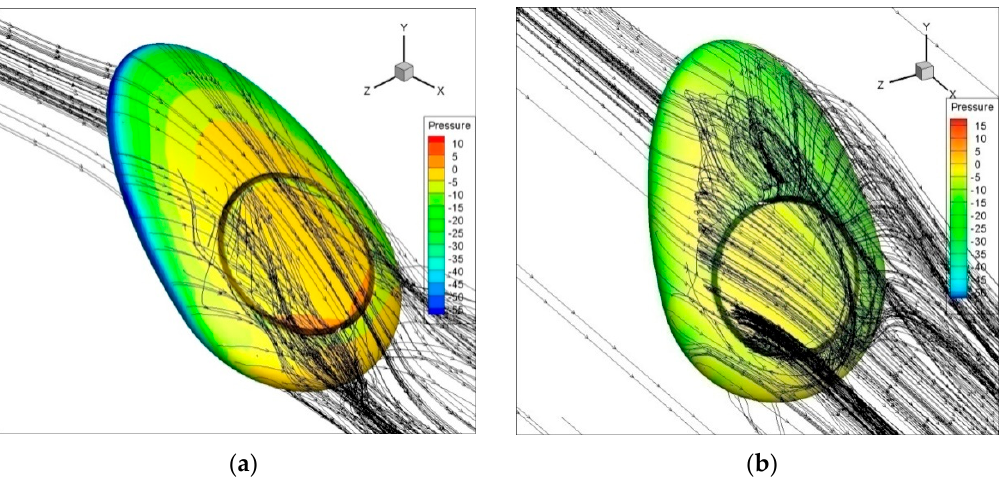
Figure 15. The flow behavior of the hybrid airship for δ = 0.0416 at ( a ) α = 40 ◦ (pre stall region) and ( b ) α = 60 ◦ (post- stall